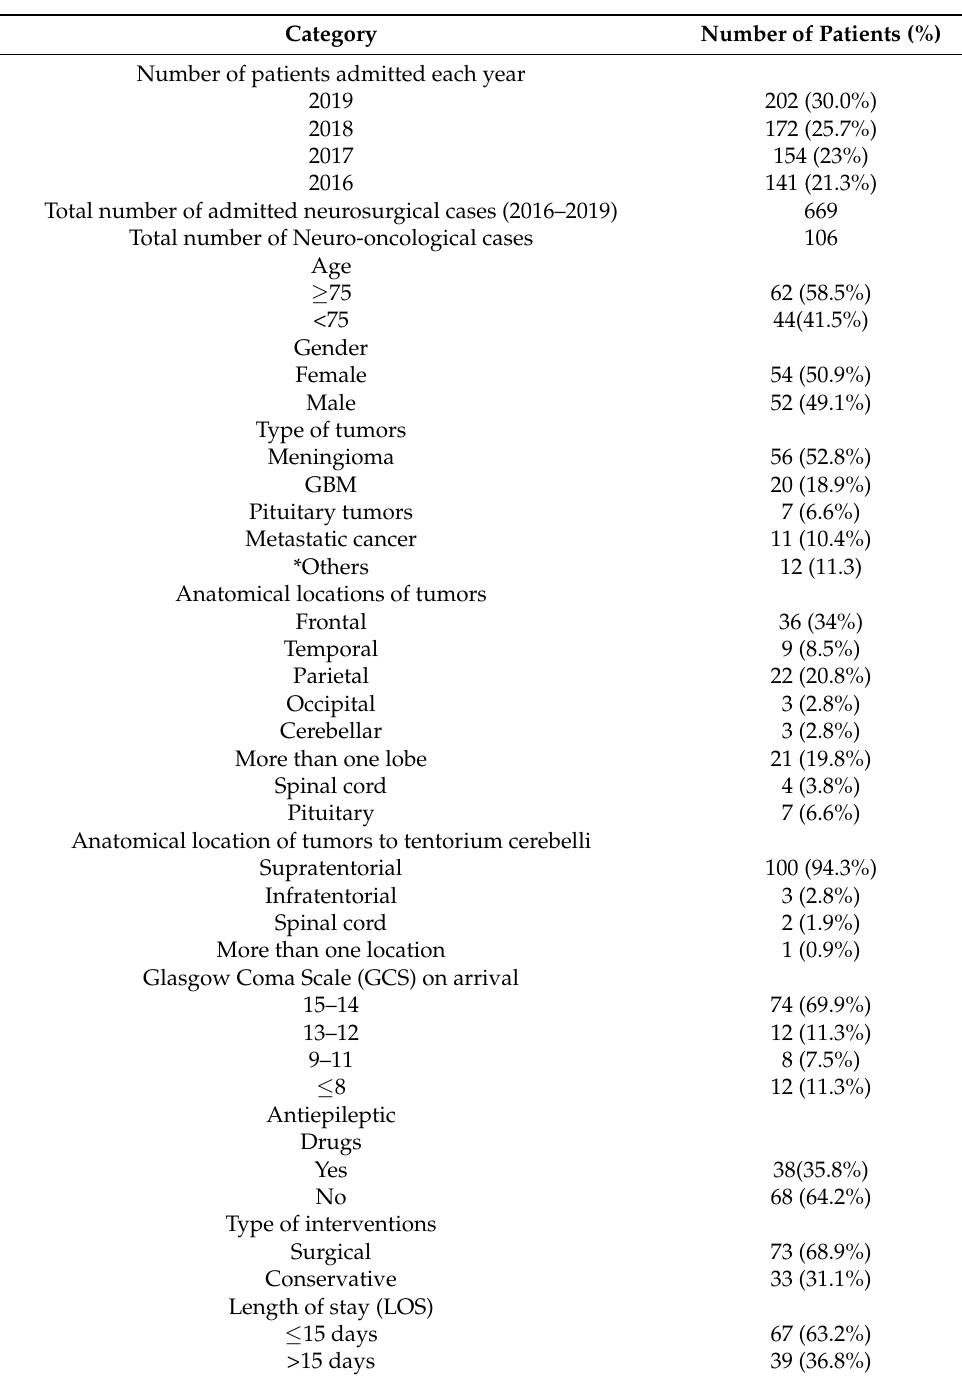
Table 1. Demographic characteristics of the included